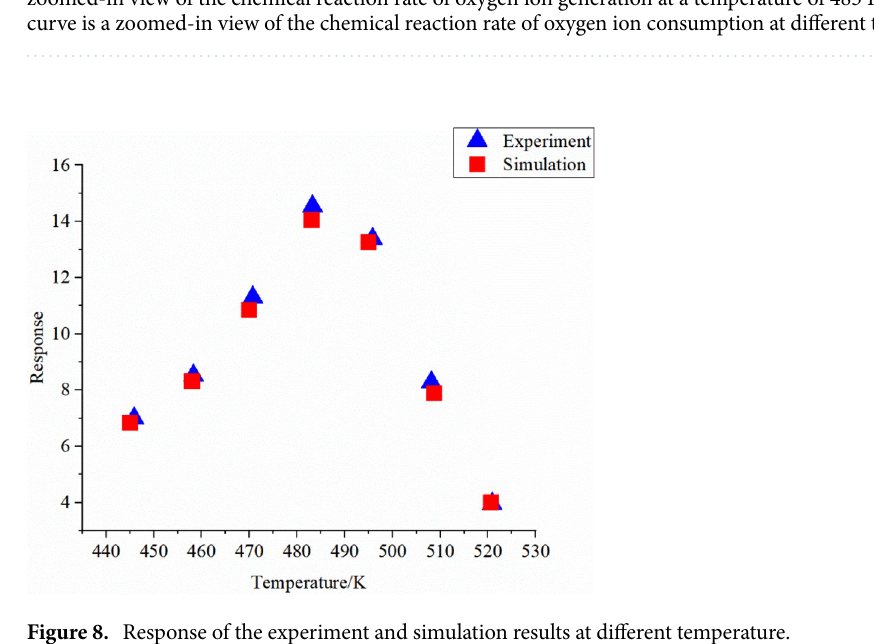
Figure 8. Response of the experiment and simulation results at different